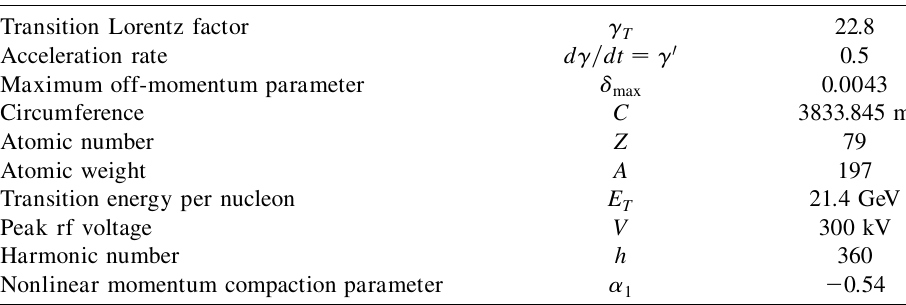
TABLE I. RHIC parameters for fully stripped gold ions. Transition Lorentz factor